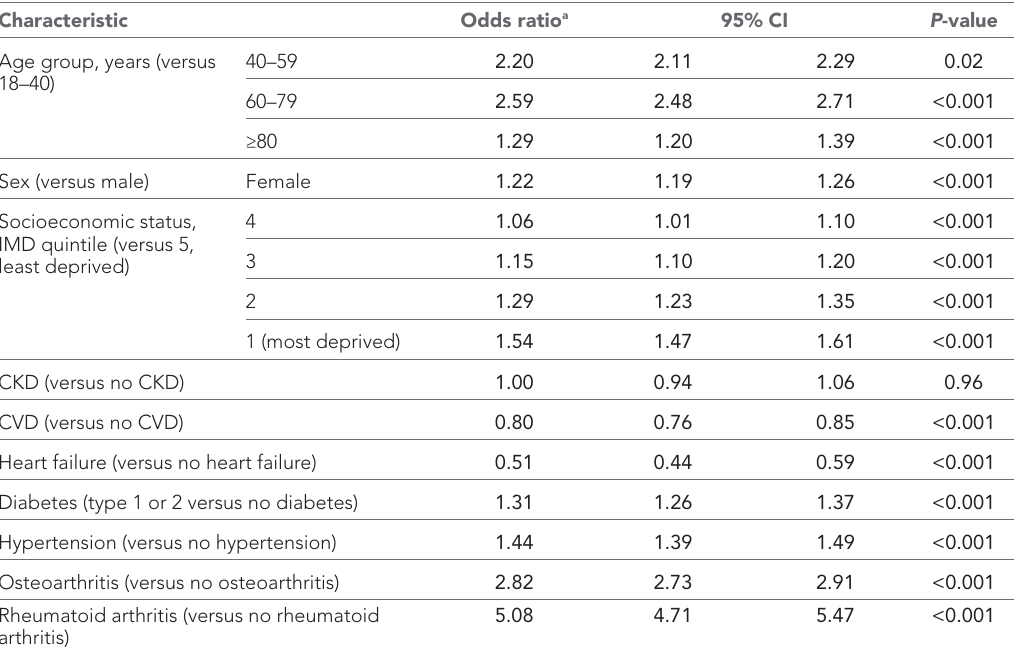
Table 2 Univariate associations with NSAID prescription at baseline